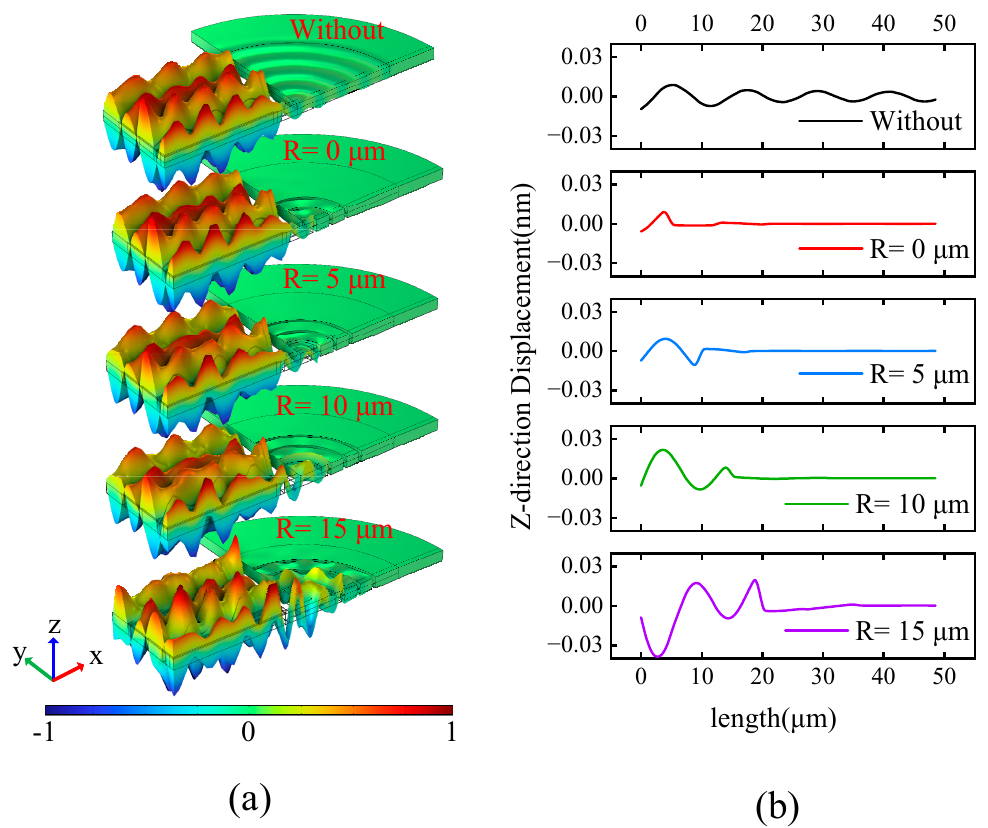
Figure 8. ( a ) The vibration mode of the resonator in the resonant mode; ( b ) The Z-direction of the A-A‘ is the displacement diagram.